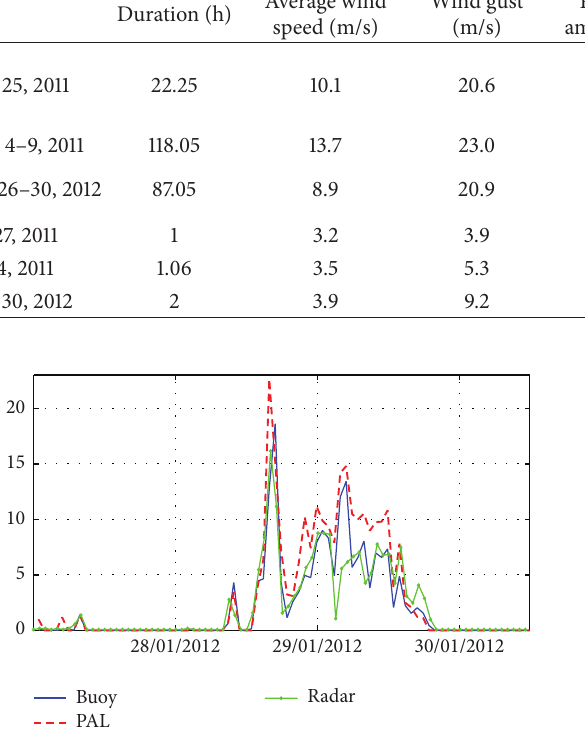
Figure 10: Buoy, PAL, and radar rainfall time series collected during the violent storm on late January 2012 over the buoy